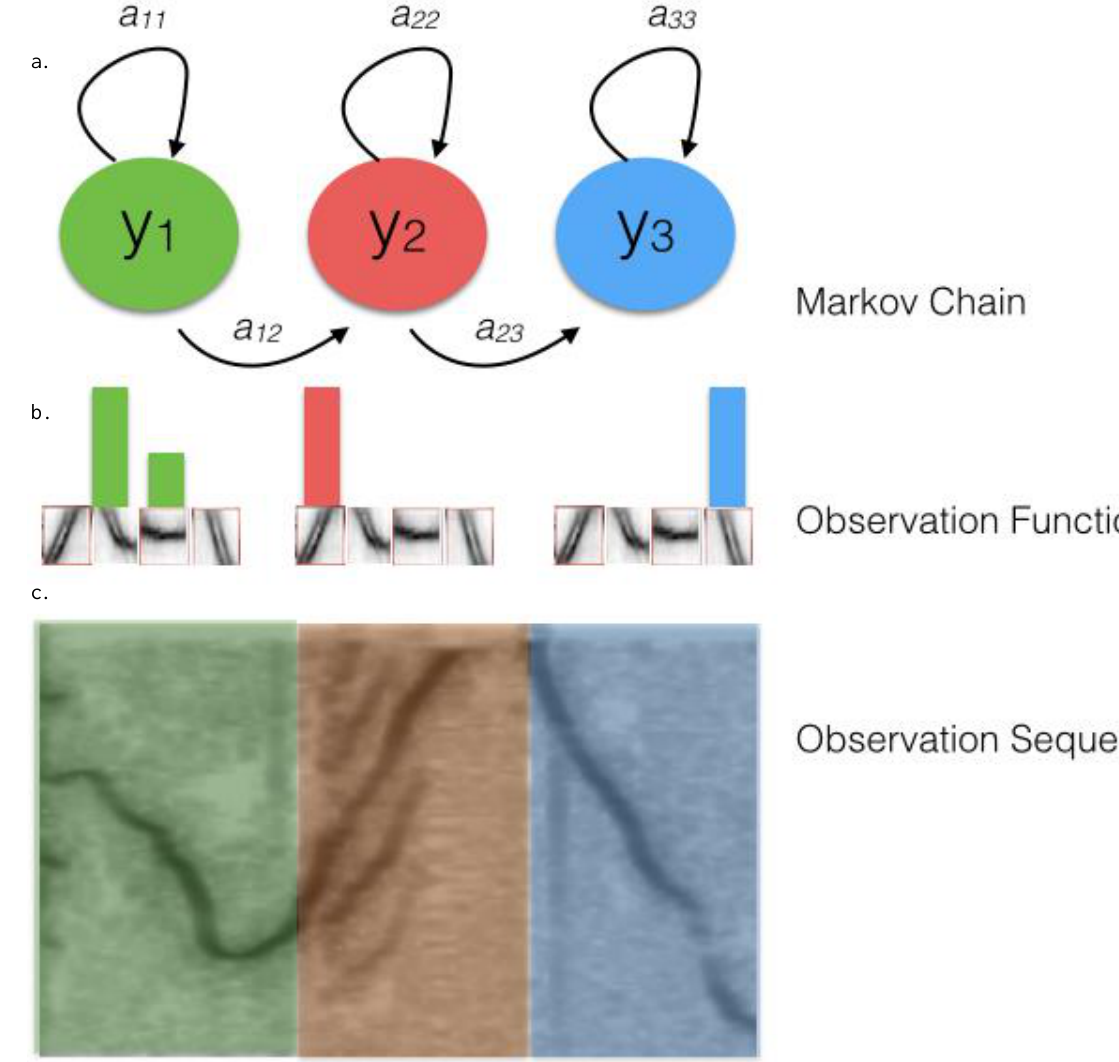
Figure 12. A hidden Markov model with three states. (a) The Markov chain defining the transition function. (b) The observation function for a feature space with four dimensions. Each of the histograms represents a mean vector of a multivariate Gaussian. Each dimension in the mean vector represents the influence of a cluster. (c) A hypothetical alignment of a whistle to the model’s states. The visualization shows the spectrogram of the whistle. The colors represent the assignment of each sample to a